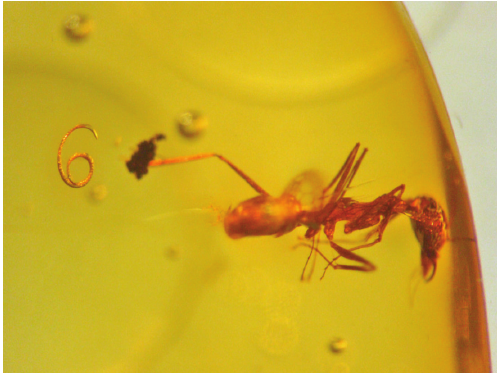
Figure 5: Heydenius myrmecophila adjacent to its Linepithema ant host in Dominican amber.